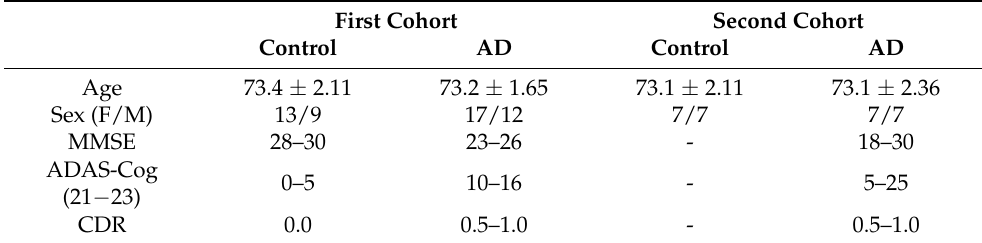
Table 1. Demographics and clinical